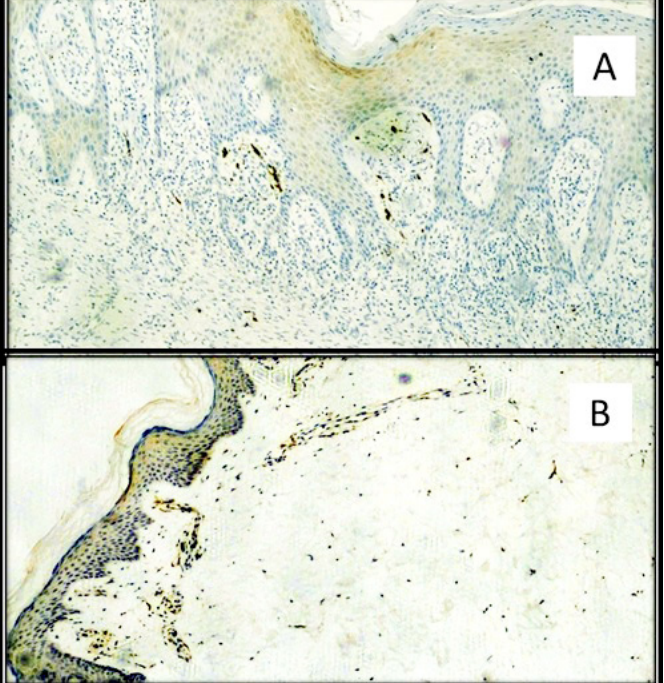
Figure 8. ( A ) Immunostaining for HO-1: note the positivity of a few inflammatory cells available mainly subepithelial in the skin of a patient positive for SARS-CoV-2 (Immunohistochemistry, Original Magnification: 40×). The light brown color